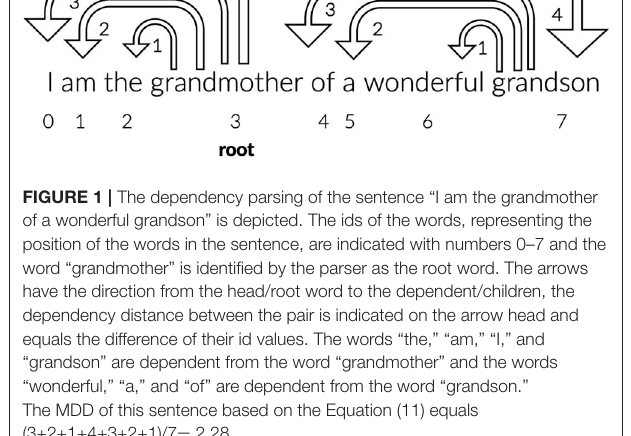
demographics, through the iPROGNOSIS app, (2) a dataset with 36,000 typing sessions with keystroke dynamics from 39 subjects (PD/HC:22/17), (3) a subset of the previous dataset with 7,600 typing sessions, drawn from de novo PD patients and the same HC ( de novo PD/HC: 9/17), (4) the union of the first two datasets with 252,000 typing sessions with keystroke dynamics